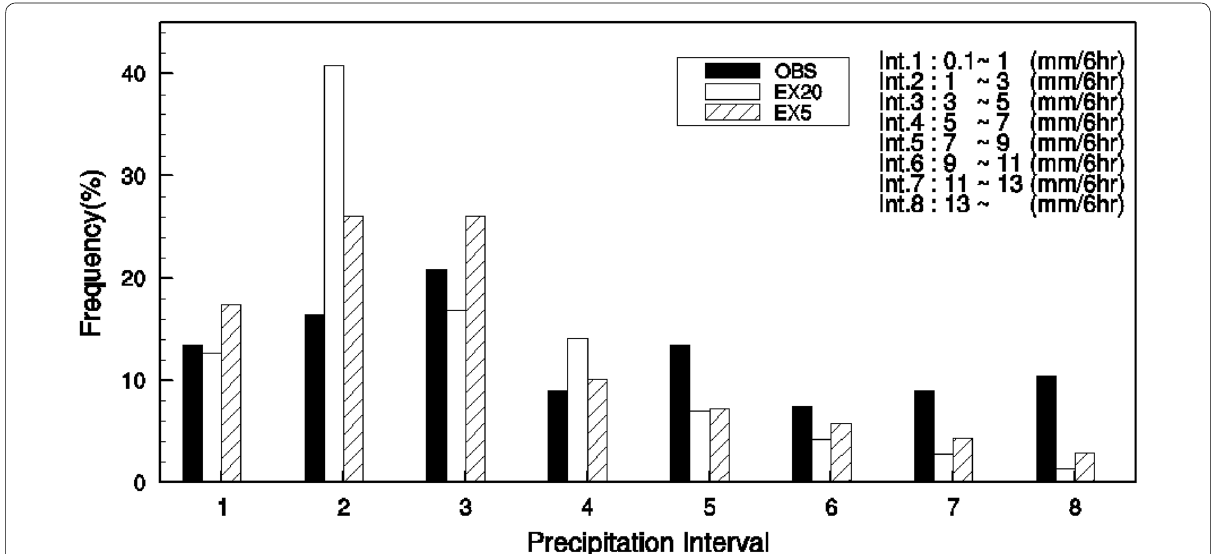
Fig. 6 Station‑averaged 6‑h accumulated precipitation intensity over the Korean Peninsula (125–130 °E, 34–39 °N) for the 18 days in observation and experiments with 20‑km (EX20) and 5‑km (EX5) horizontal resolutions. The frequency of intensity within a given interval is represented as the percentage of the total number of rain occurrences (adapted from Choi et al.